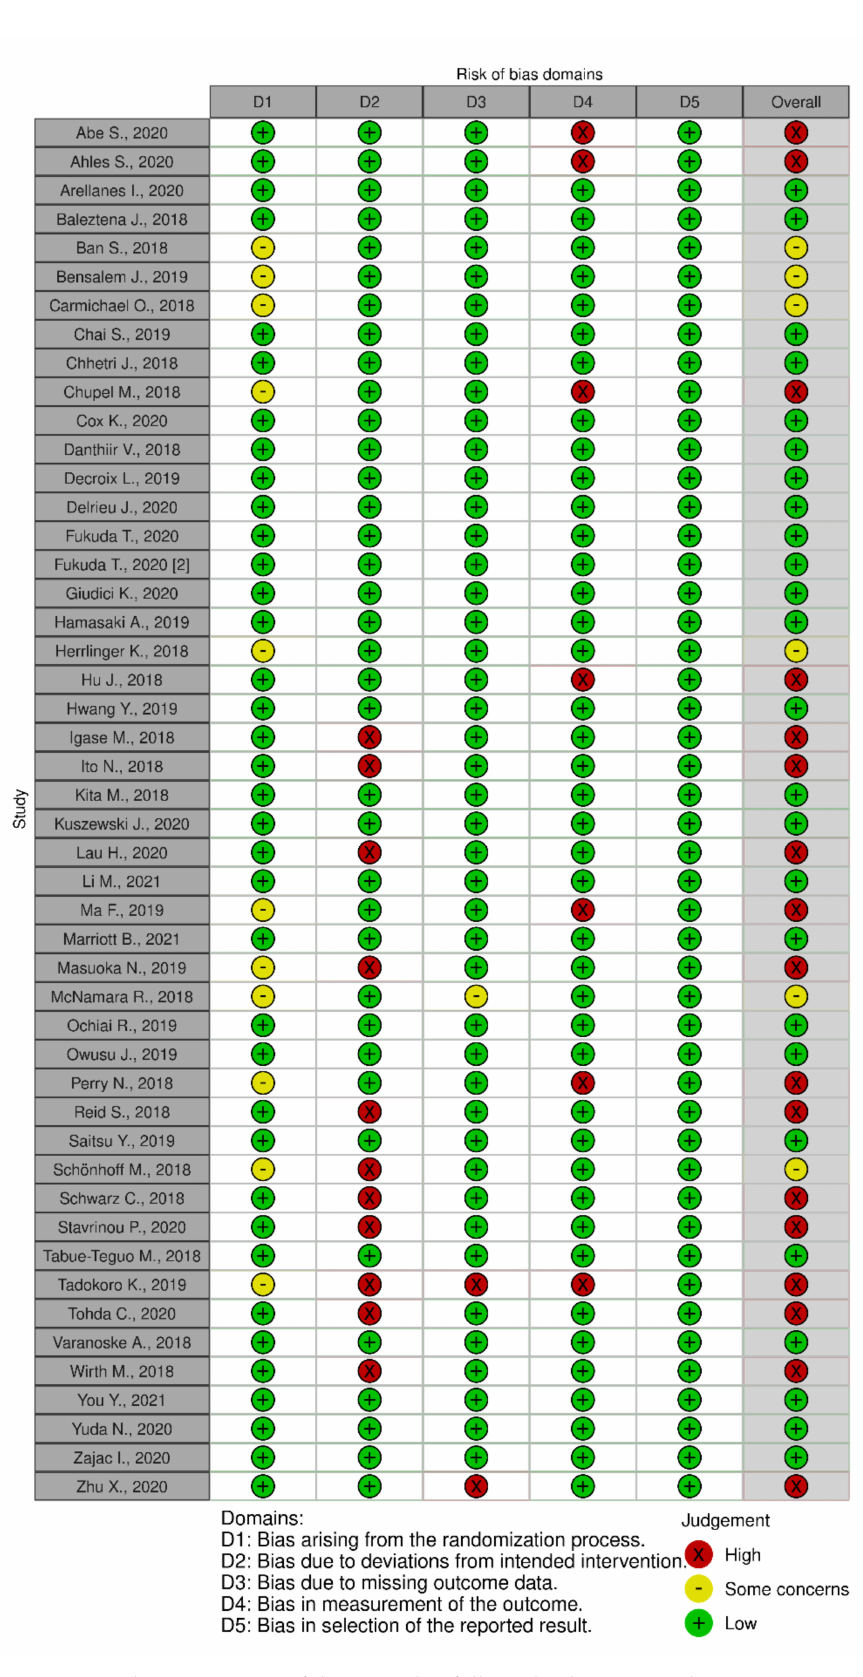
Figure 4. Quality assessment of the RCTs that followed a dietary supplement